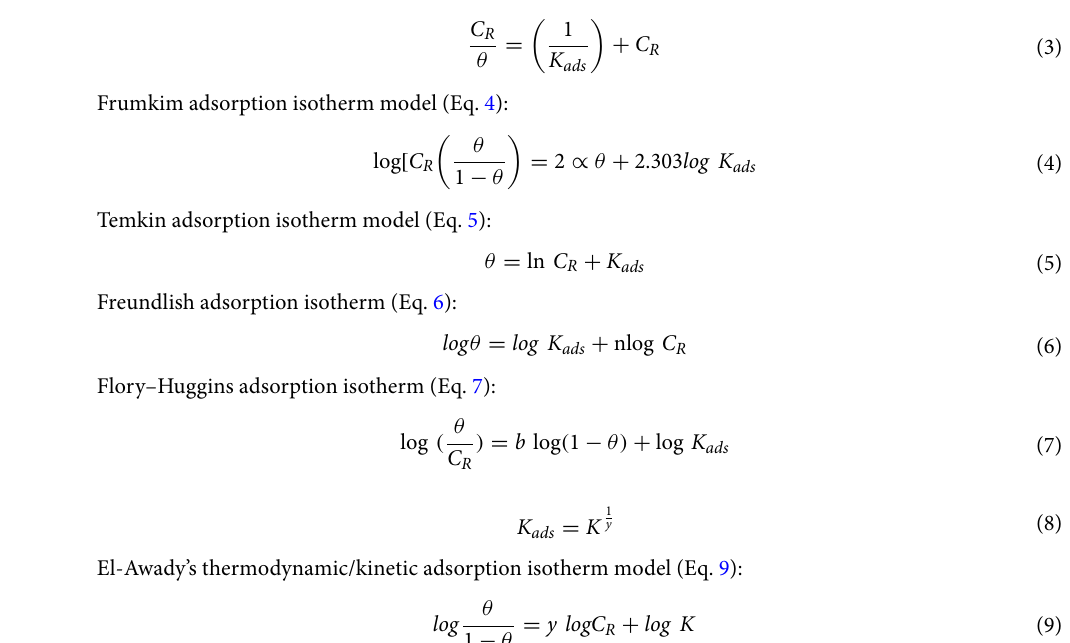
Adsorption isotherm and determination of adsorption thermodynamics parameters. The mechanism by which organic inhibitors attach to the LCS surface is discussed in the adsorption isotherm. Fit- ting the linear isotherm models (Frendlich, Langmuir, Frumkim, Tempkin, and Flory Huggins isotherm mod- els) expressed in linear equations with the corrosion rate ( C R ) and the percentage of Ɵ of the APPH using the following Eqs. (3–9) 47–51 . The Langmuir adsorption isotherm model (Eq. 3):